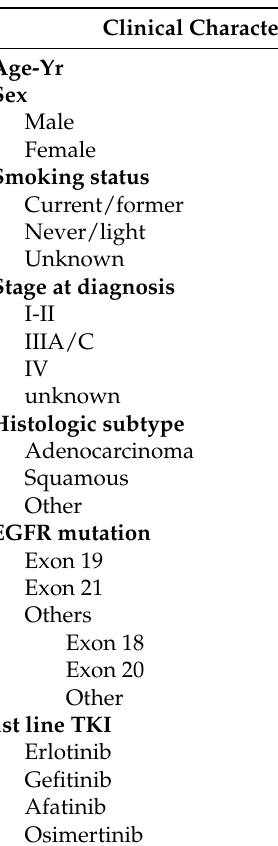
Table 1. Clinical characteristics of the whole population and the primary metastatic